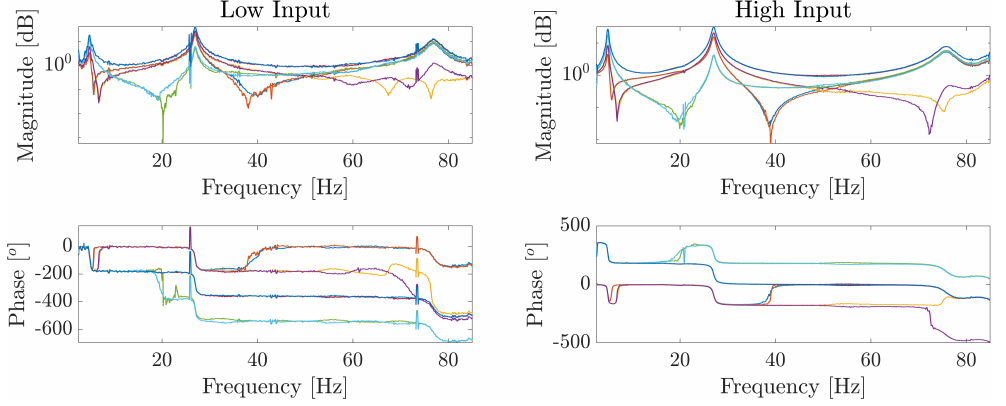
Figure 12. Main spar: FRFs of the low- and high-input scenarios. All channels are superimposed for conciseness.